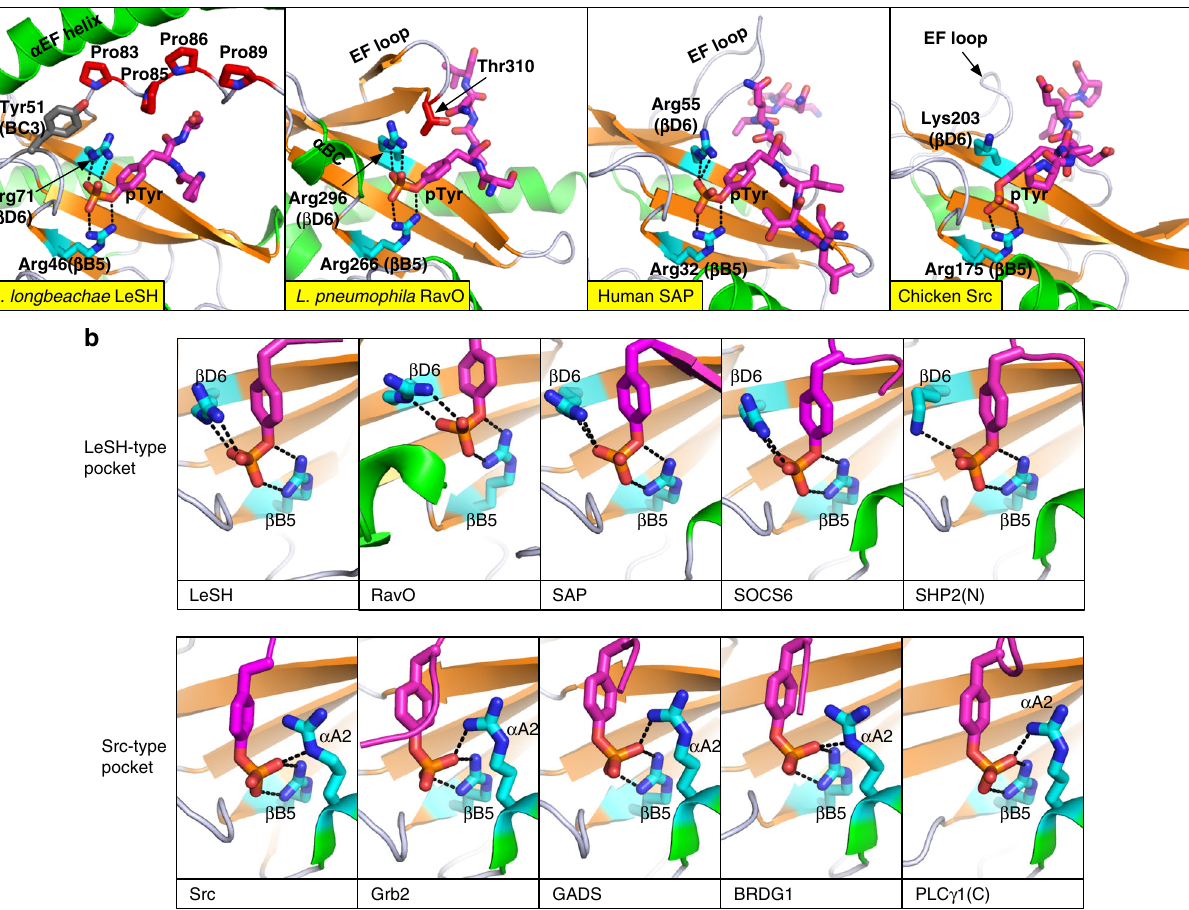
Fig. 5 Comparison of the pTyr-binding pocket between Legionella and animal SH2 domains. a The pTyr-binding pockets of the LeSH and RavO SH2 domains. The human SAP and chicken Src SH2 domains are shown for comparison. b Classi fi cation of pTyr conformation based on structural alignment of the LeSH and RavO SH2 domains with eight eukaryotic SH2 domains. Residues that contribute to salt bridges are shown in cyan sticks. The following high-resolution (resolution ≤ 2 Å and the crystallographic free-R <0.25) crystal structures were used here: SAP (PDB code 1D4W), SOCS6 (2VIF), SHP2 (N-terminal SH2, 3TKZ), Src (1SHA), Grb2 (1JYR), GADS (1R1Q), BRDG1 (3MAZ), and PLC γ 1 (C-terminal SH2,